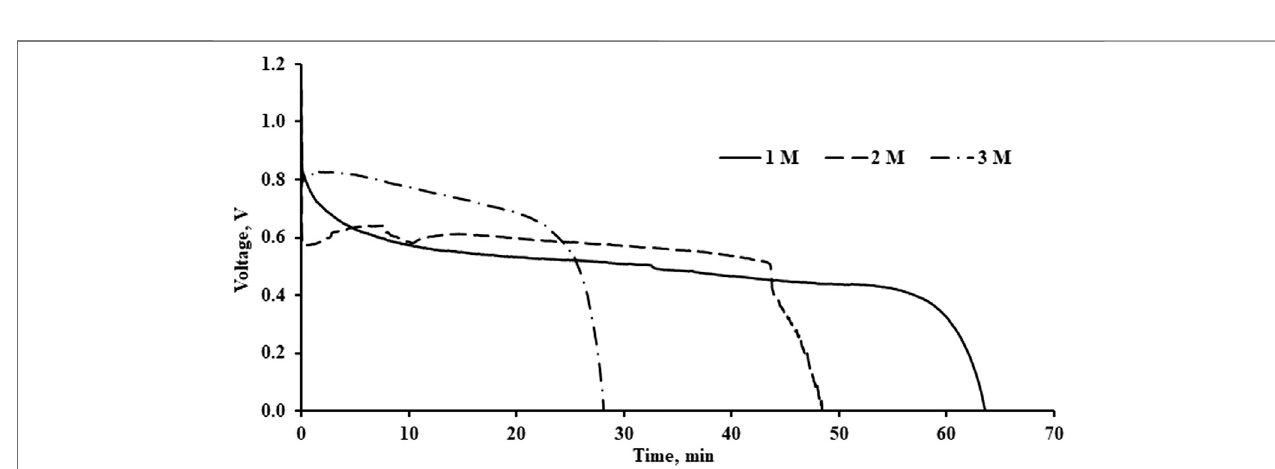
FIGURE 5 | Discharge performance of Al-air battery with different KOH concentration with discharge current of 20 mA.